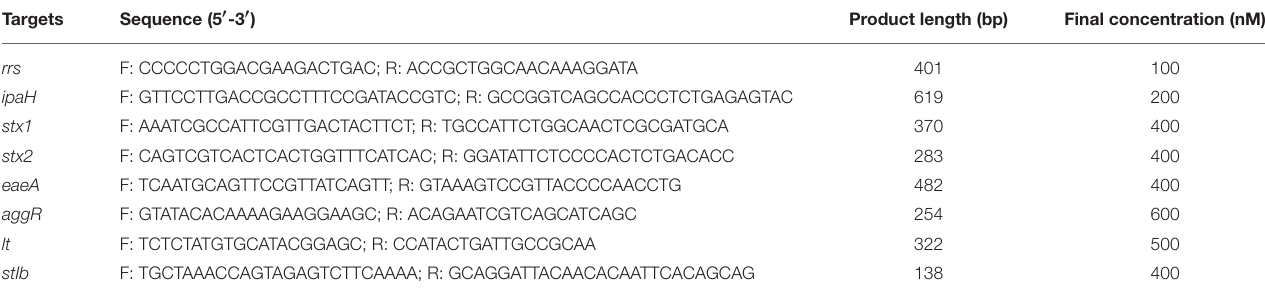
TABLE 1 | Primer sequences for multiplex PCR of DEC (Zhao et al., 2011).